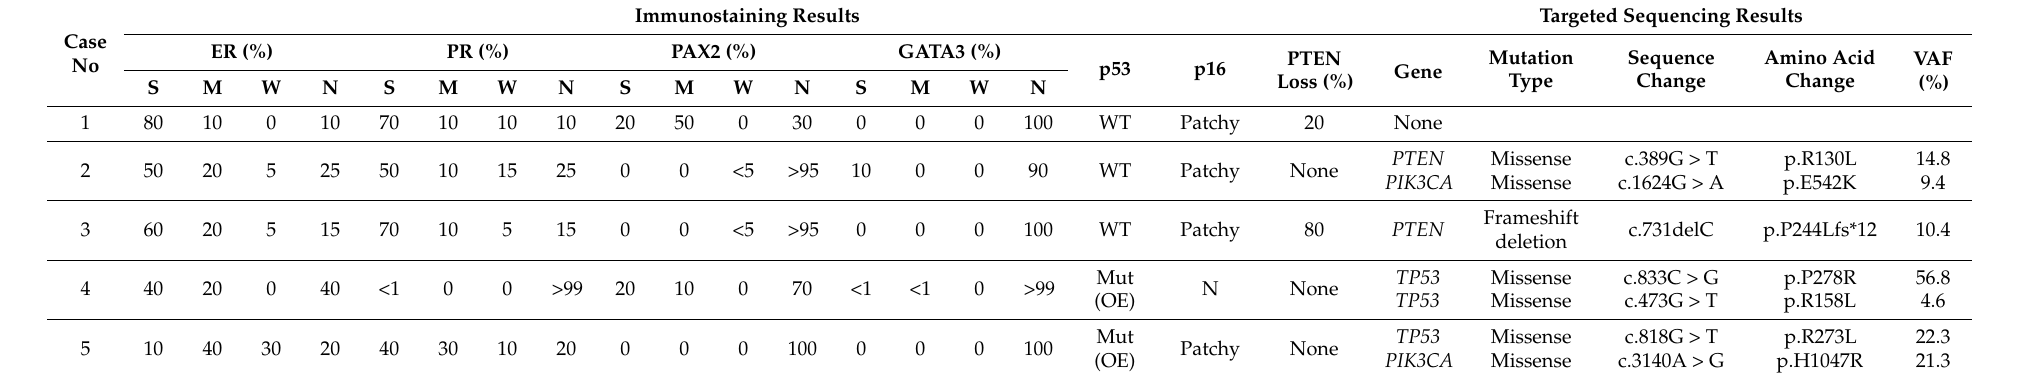
Table 4. Results of immunostaining and targeted